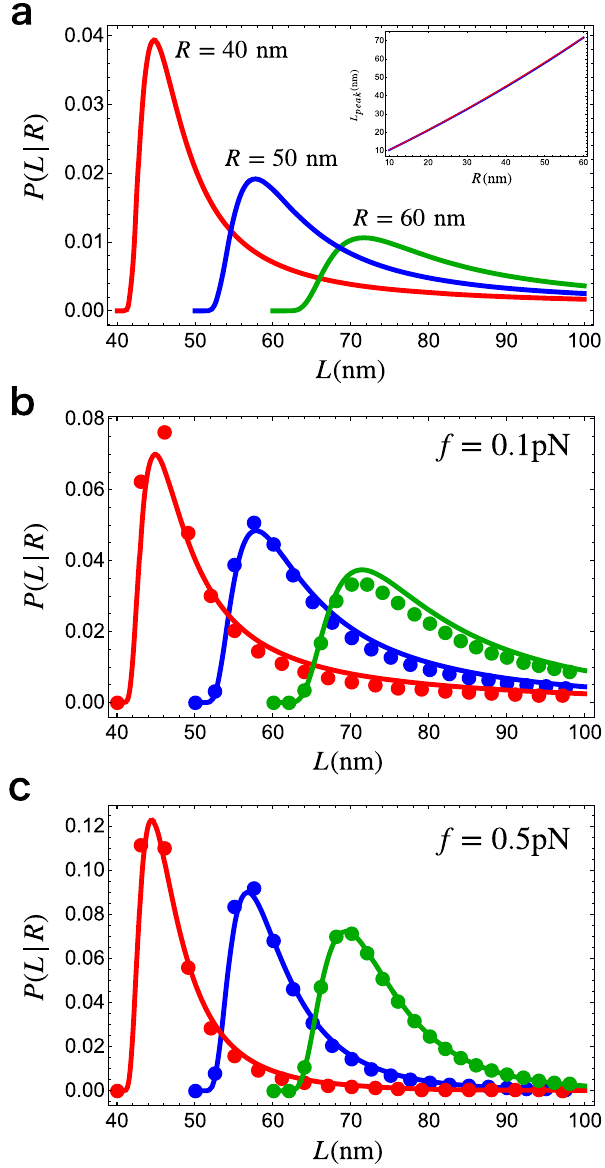
Fig. 2 Distributions of the captured length of DNA. a Plots of P ( L ∣ R ) for different R values; R = 40 nm (red), R = 50 nm (blue), and R = 60 nm (green). Inset: Peak position ( L peak ) of P ( L ∣ R ), evaluated numerically by setting by d P ( L ∣ R )/d L to zero, as a function of R . The dotted red line is a fi t, L R exp ð aR Þ with a = 0.003 nm − 1 . b , c The distributions of L for peak ¼ different R and f . R = 40 nm (red), R = 50 nm (blue), and R = 60 nm (green). The dots are from Eq. (2) and the solid lines are the approximate probability distribution Eq. (3). We used the persistence length of DNA, l DNA ¼ 50 p